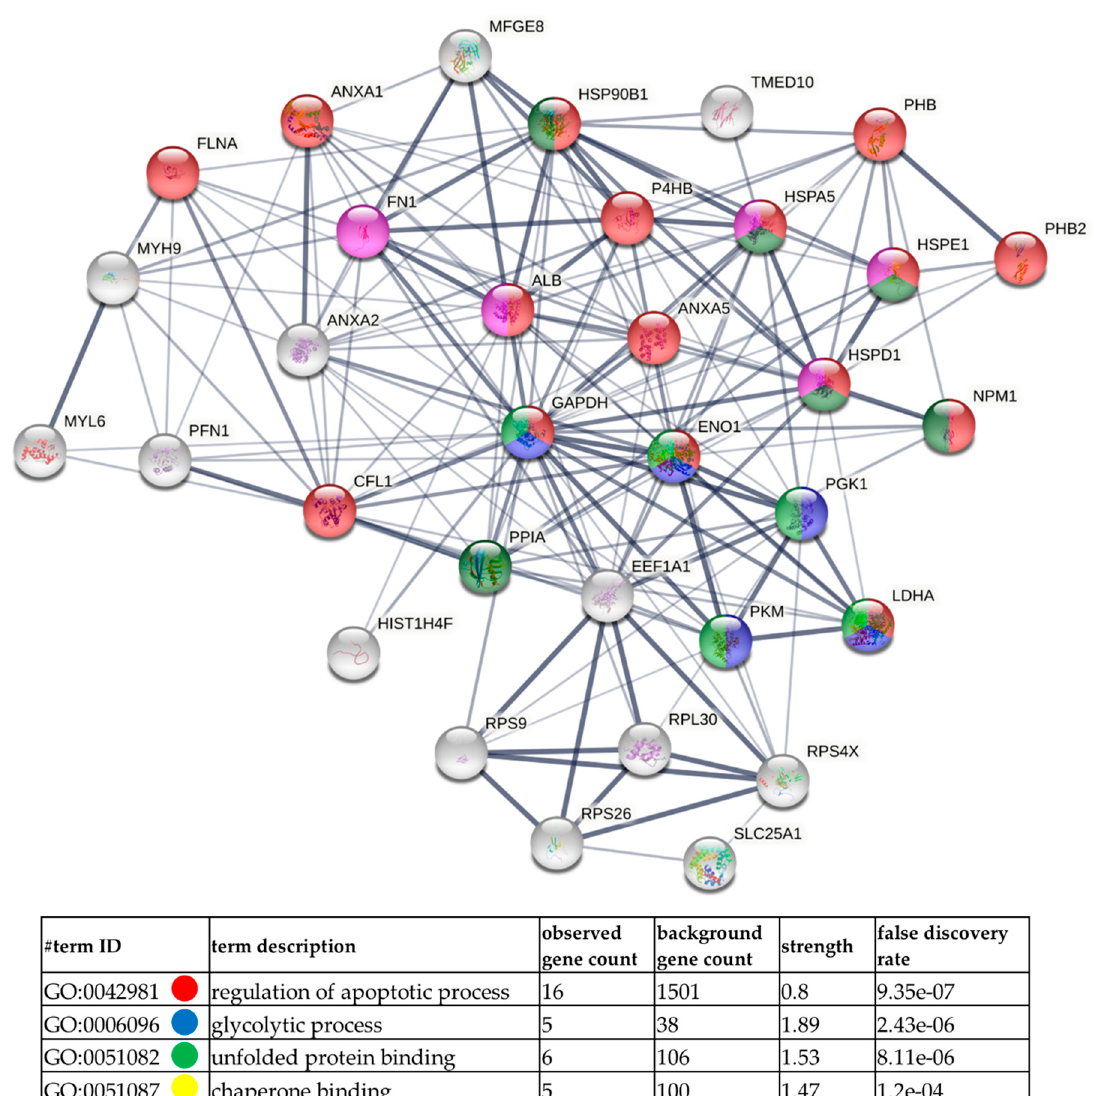
Figure 8. Diagram of functional protein association networks prepared with the use of STRING v. 11.0 software for 33 (~2.5%) of the most abundant proteins identified in T-24-derived ectosomes. The selected strongly represented pathways are presented on interactome. Complete results, including much more complex networks with 10% of most abundant proteins (135 proteins), are provided in Supplementary Data S3.